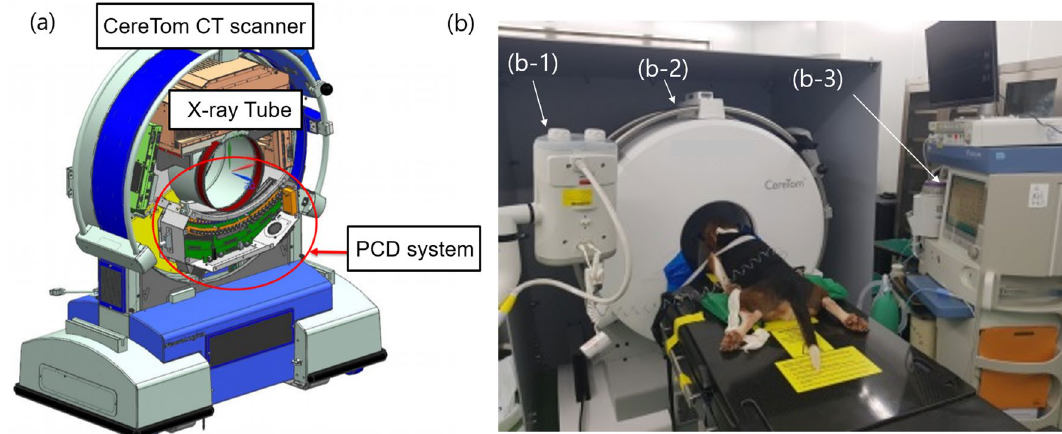
Figure 2. ( a ) Illustration of the photon-counting detector computer tomography (PCD CT) system placed inside the CereTom Scanner. ( b ) Beagle dog positioned for scanning. (b-1) CT injection system for injecting contrast medium. ( b-2 ) PCD CT system. ( b-3 ) Monitoring system for temperature, blood pressure, peripheral oxygen saturation, and end-tidal carbon